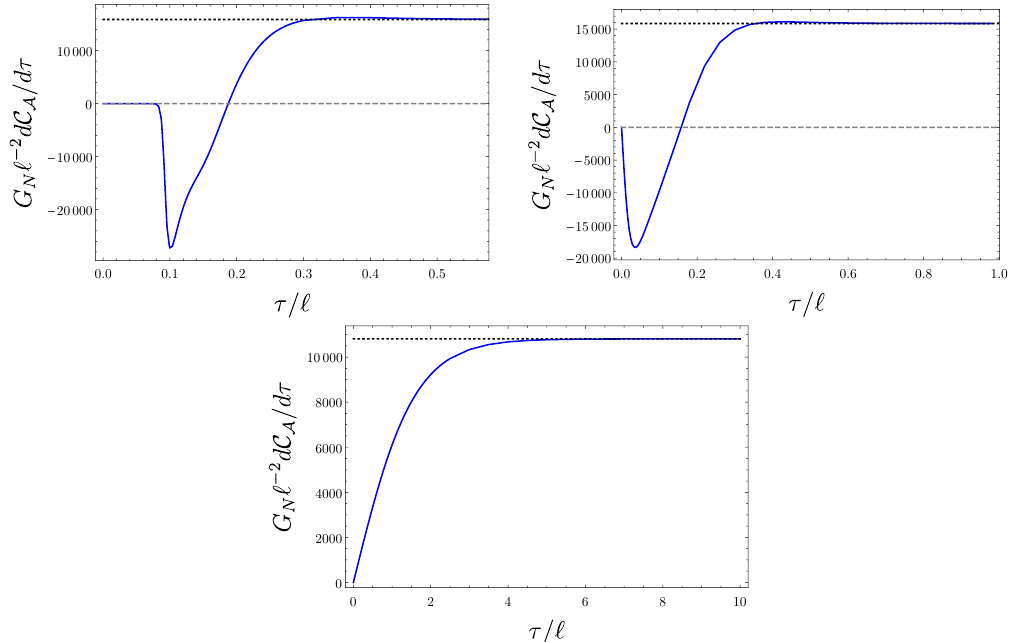
Figure 11. Here we show plots of the growth rate of complexity as a function of time. In each plot we have set r + /‘ = 10 , while the different plots correspond to r − /r + = 1 / 20 , 1 / 10 , 3 / 4 (left to right). We have set ‘ ct = 1 . The dotted black line shows the growth rate of complexity in the limit τ → ∞